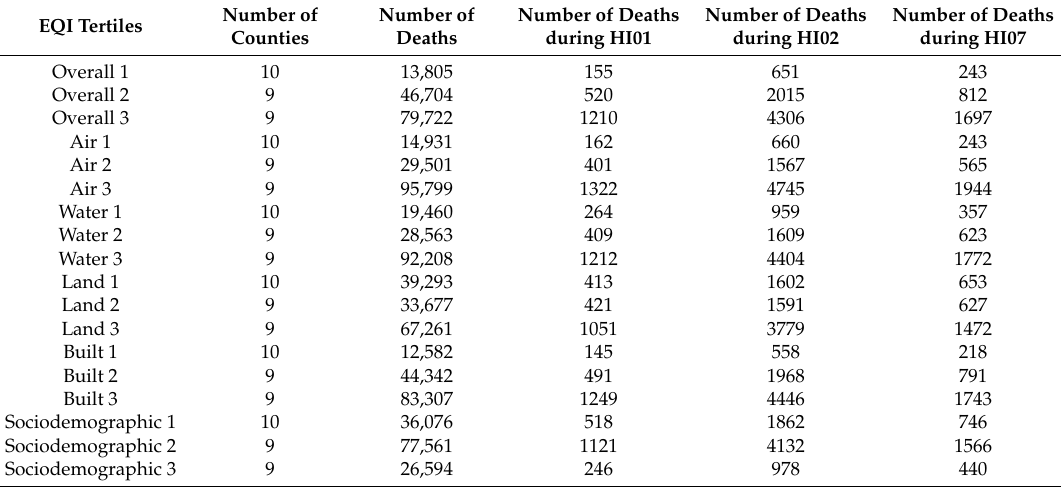
Table 1. Summary of data on the Environmental Quality Index (EQI), Heatwave Indices (HI) and non-accidental deaths in Alabama metropolitan counties 1997–2010.